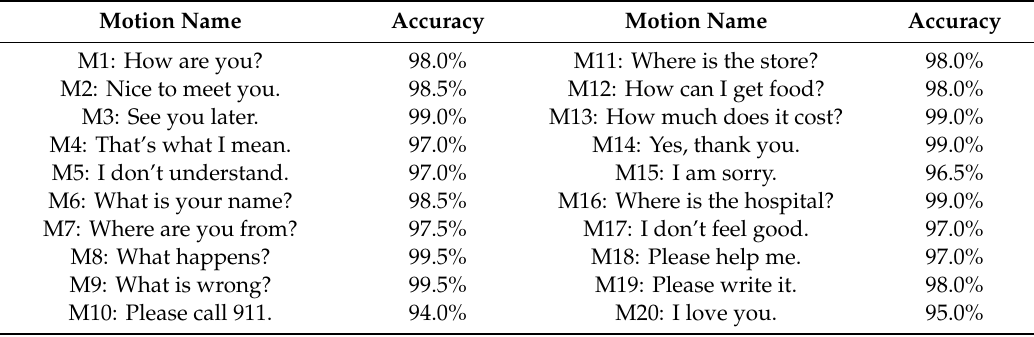
Table 8. The classification accuracy of 20 motions with the bilinear model.